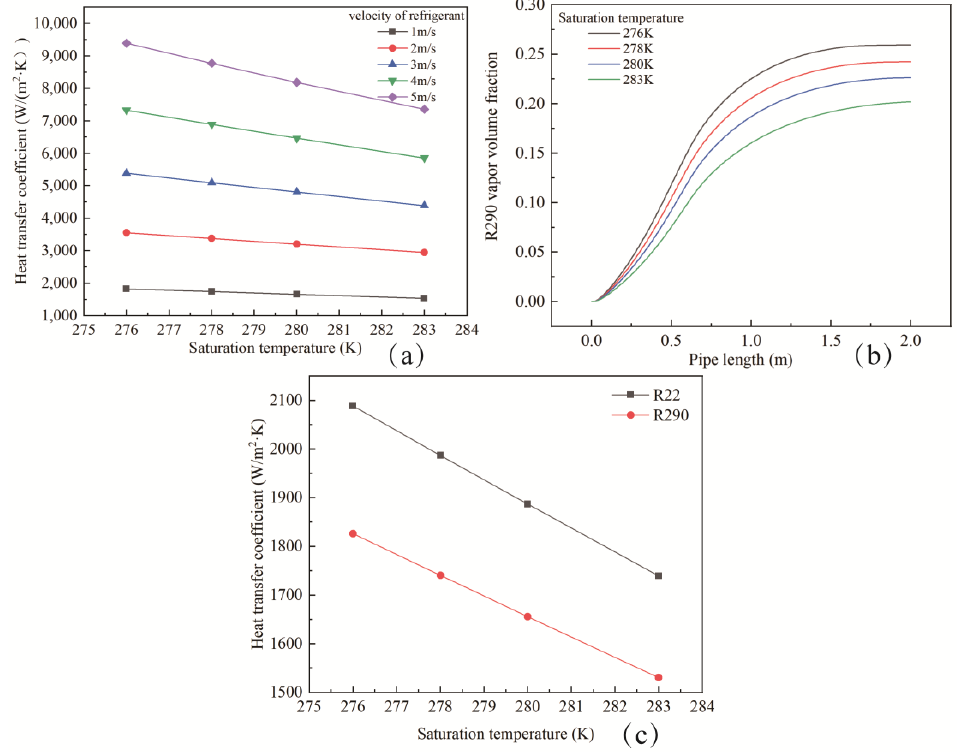
Figure 8. The impact of ( a ) saturation temperature on HTC, ( b ) R290 volume fraction at the inner tube wall surface and ( c ) HTC for R22 and R290 at different saturation temperatures.